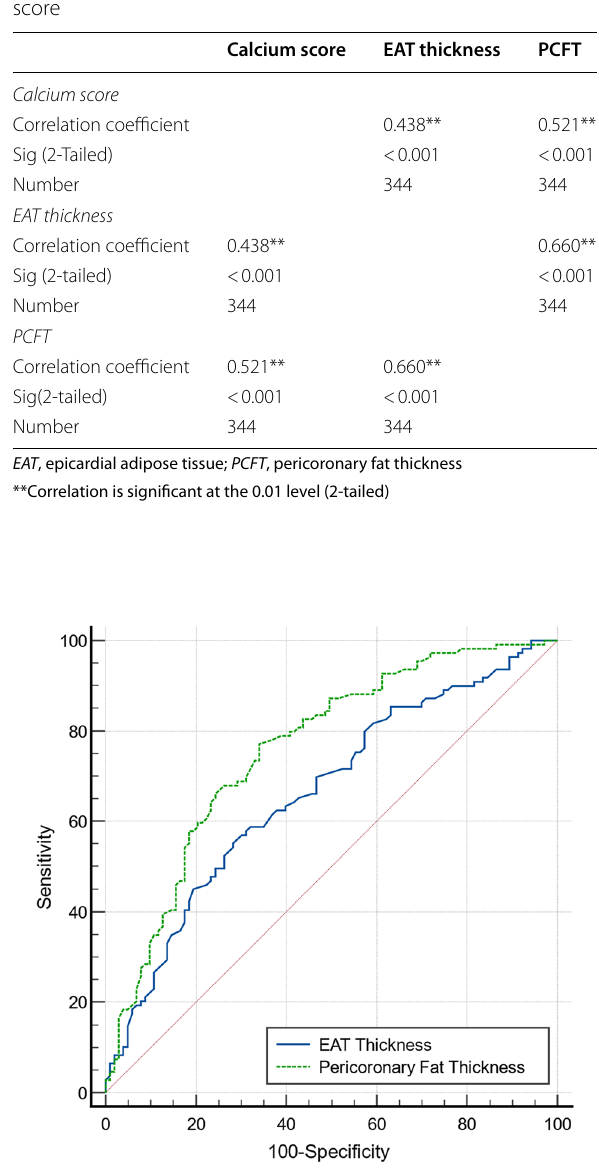
Fig. 2 ROC Curve for development of obstructive coronary artery disease by EAT thickness and pericoronary fat thickness (PCFT).